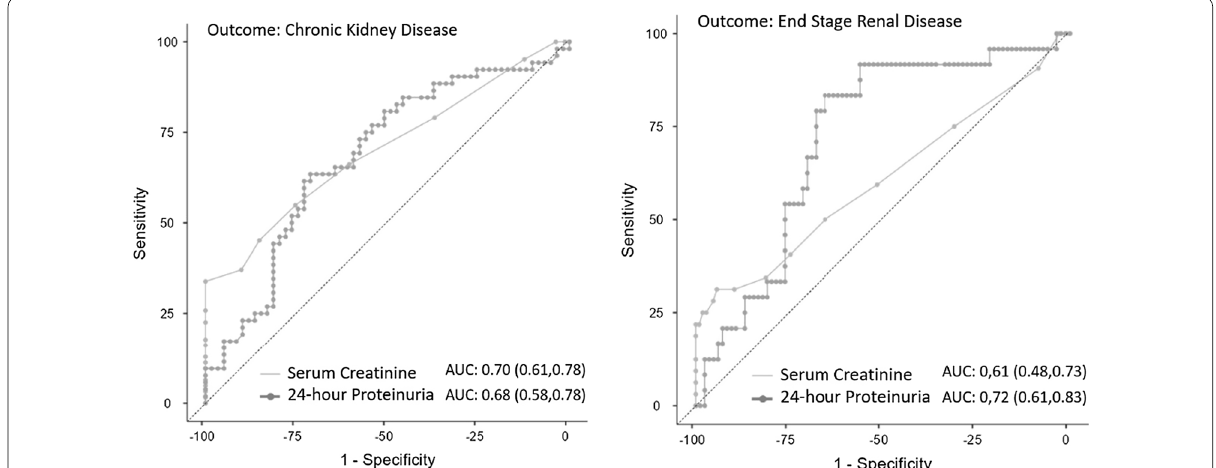
Fig. 2 Receiver operating characteristic curve of 24-h proteinuria and serum creatinine at 12 months of follow-up in patients with LN who developed chronic kidney disease and end stage renal